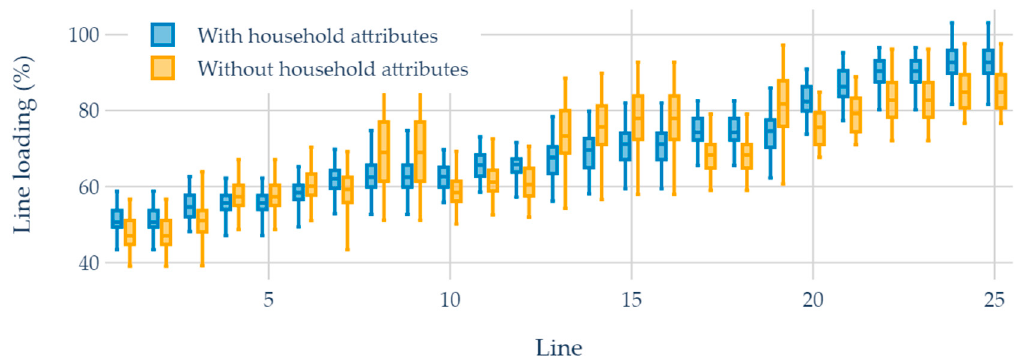
Figure 10. Comparison of line loadings based on charging point allocations with and without consideration of household attributes. Subset of 25 lines in a single grid, 50 spatial allocation variants.